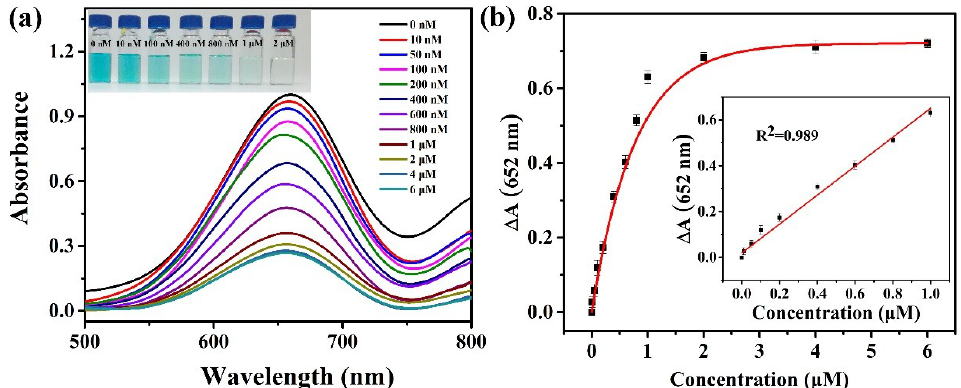
Figure 3. ( a ) Absorption spectra (inset is digital photo) of Ag + -TMB system in the presence of different concentrations of oleic acid (0 to 6 μM, from top to bottom); ( b ) Plots of Δ A versus different concentrations of oleic acid ranging from 0 to 6 μM (inset is the linear relationship between Δ A and the concentration of oleic acid from 0 to 1 μM). Experimental conditions: 0.2 M NaAc buffer (pH = 5.0), 0.3 mM of TMB and 0.175 mM of AgNO 3 , incubation time is 10 min. The error bars represented standard deviations based on three independent measurements.